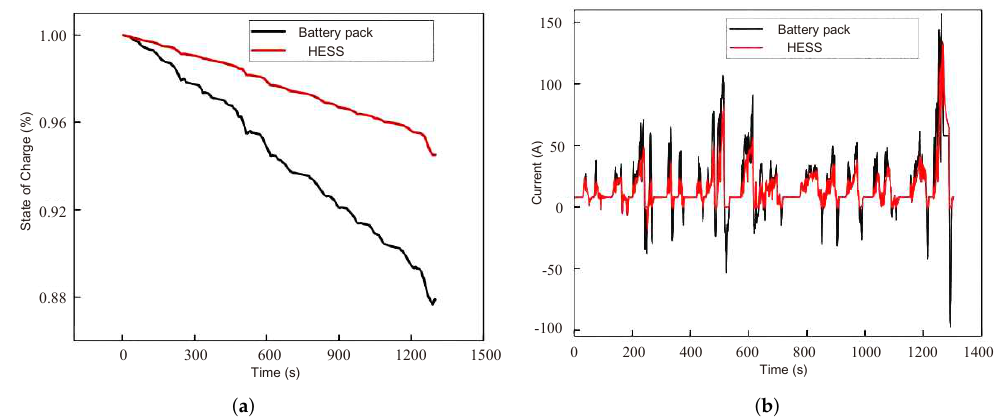
Figure 7. Experimental comparison of HESS and battery pack: ( a ) SOC curve of HESS and battery pack and ( b ) Current curve of HESS and battery pack.